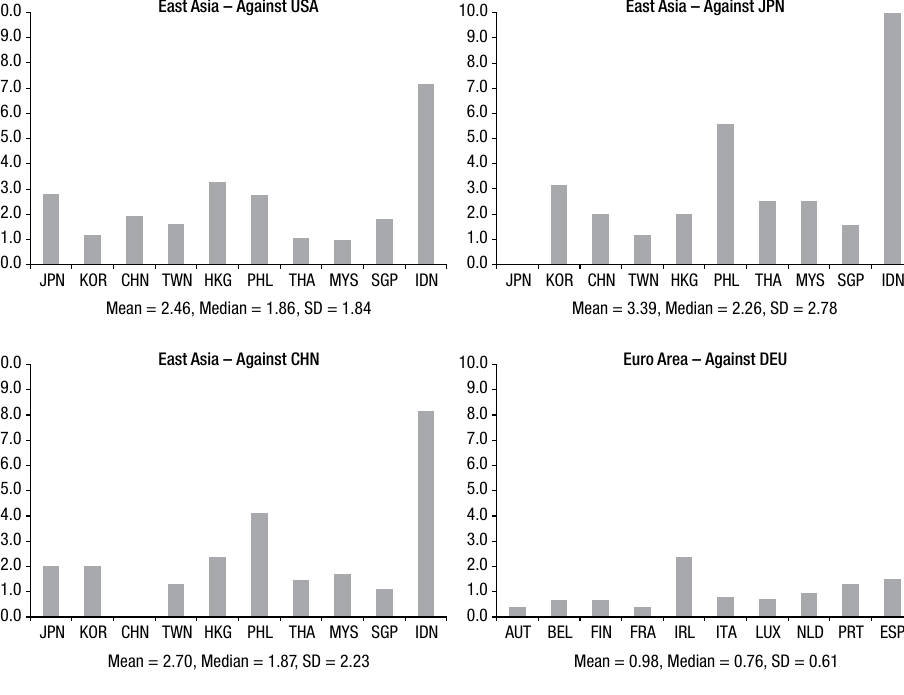
Fig. 3. CPI inflation differential (%),